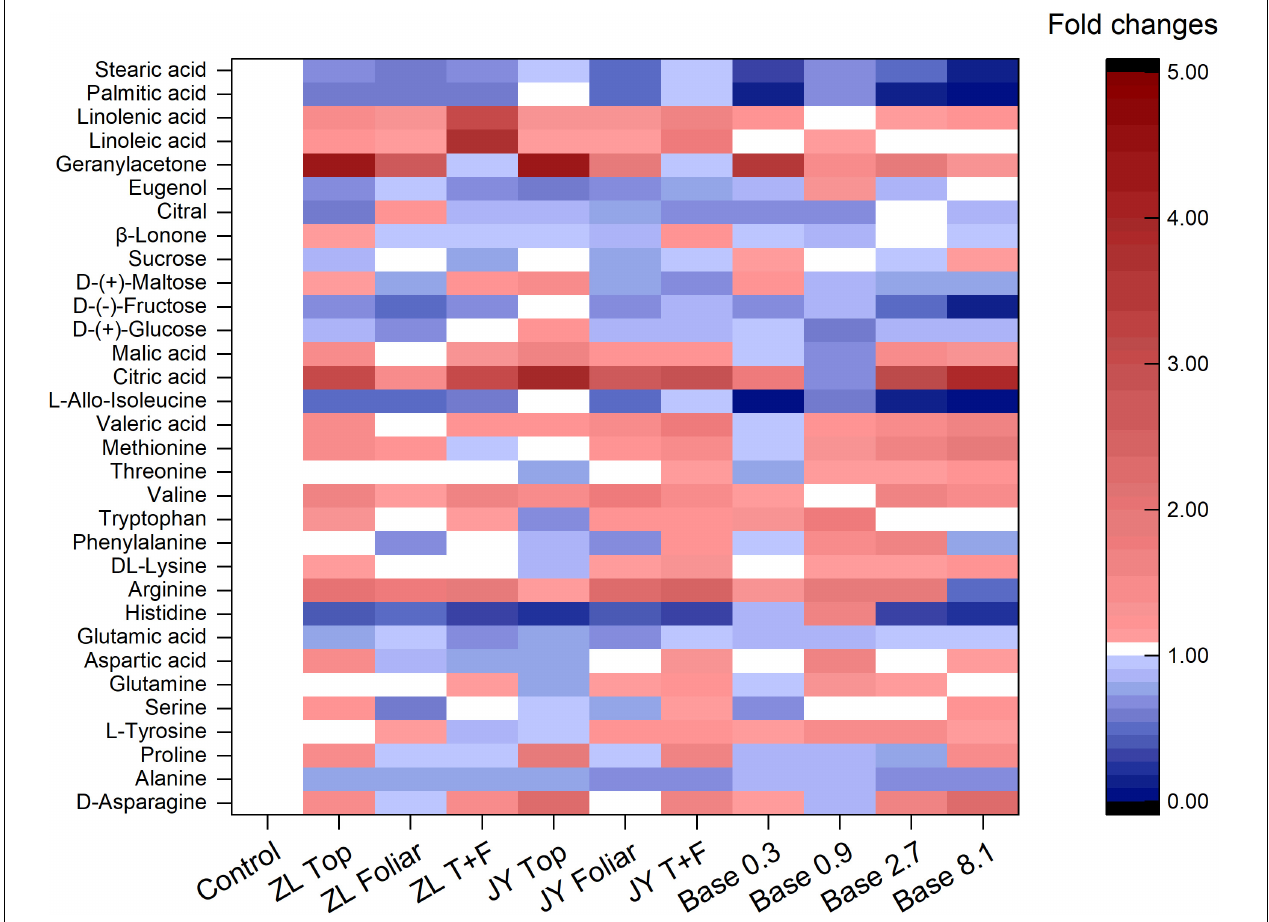
FIGURE 2 | The effect of fulvic acids on the fold changes of quality-related can carbon containing substances in fruit juices of tomato plants grown in soil cultures (Experiment 1).